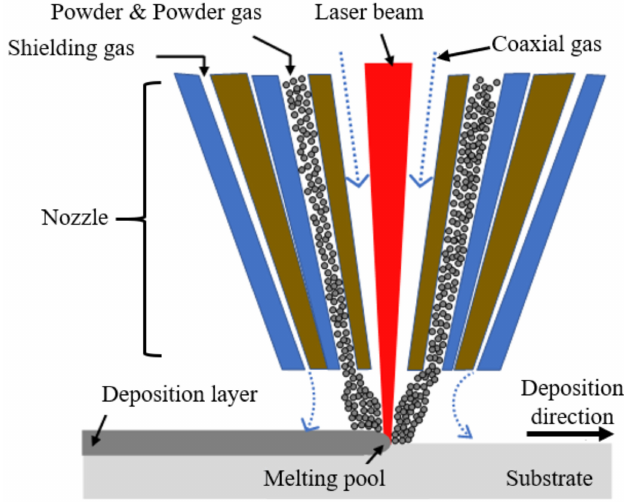
Figure 2. Schematics of direct energy deposition process.